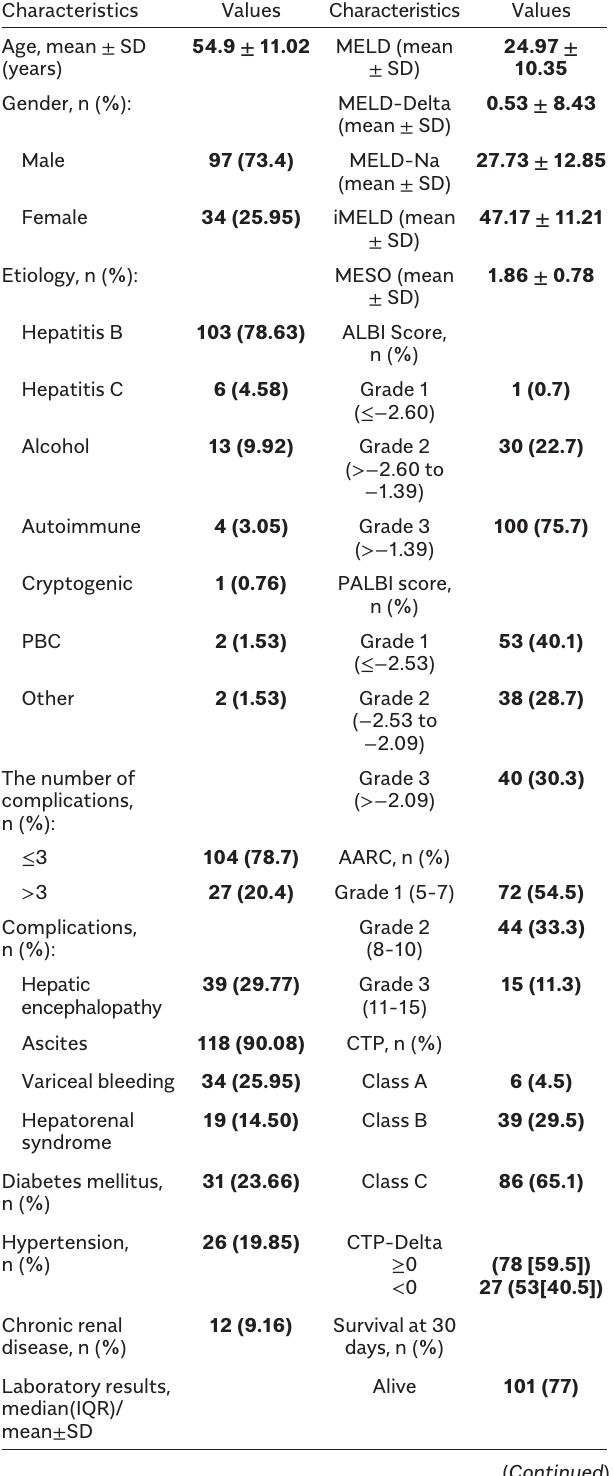
Table 1. Baseline Characteristics of Patients Characteristics